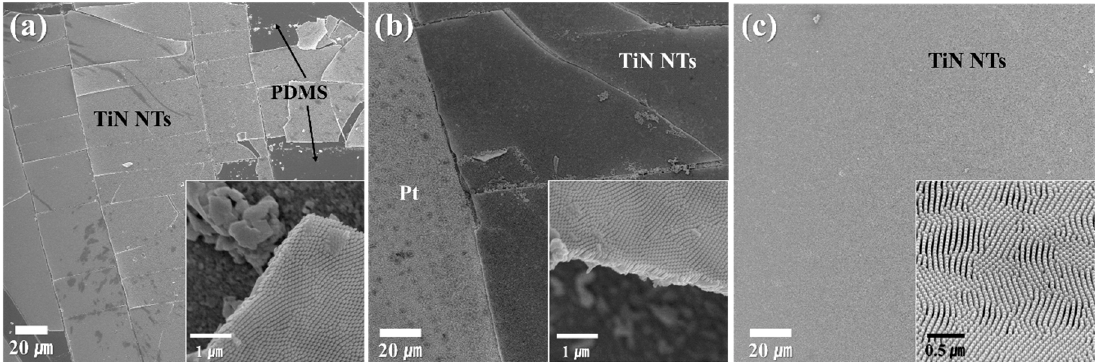
Figure 4. Surface morphologies of TiN nanotube arrays transferred to different flexible substrates: ( a ) PDMS, and ( b ) Pt layers, ( c ) Ti and Pt laminated substrate; insets correspond to magnified images.